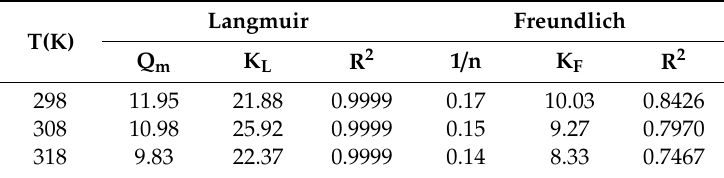
Figure 12. Adsorption isotherms for As( Ⅴ ) adsorption by CS-modified Dt (sorbent dosage: 0.4 g/L; contact Table. 40 min; pH 5). Table 2. Parameters of the Langmuir and Freundlich equation.